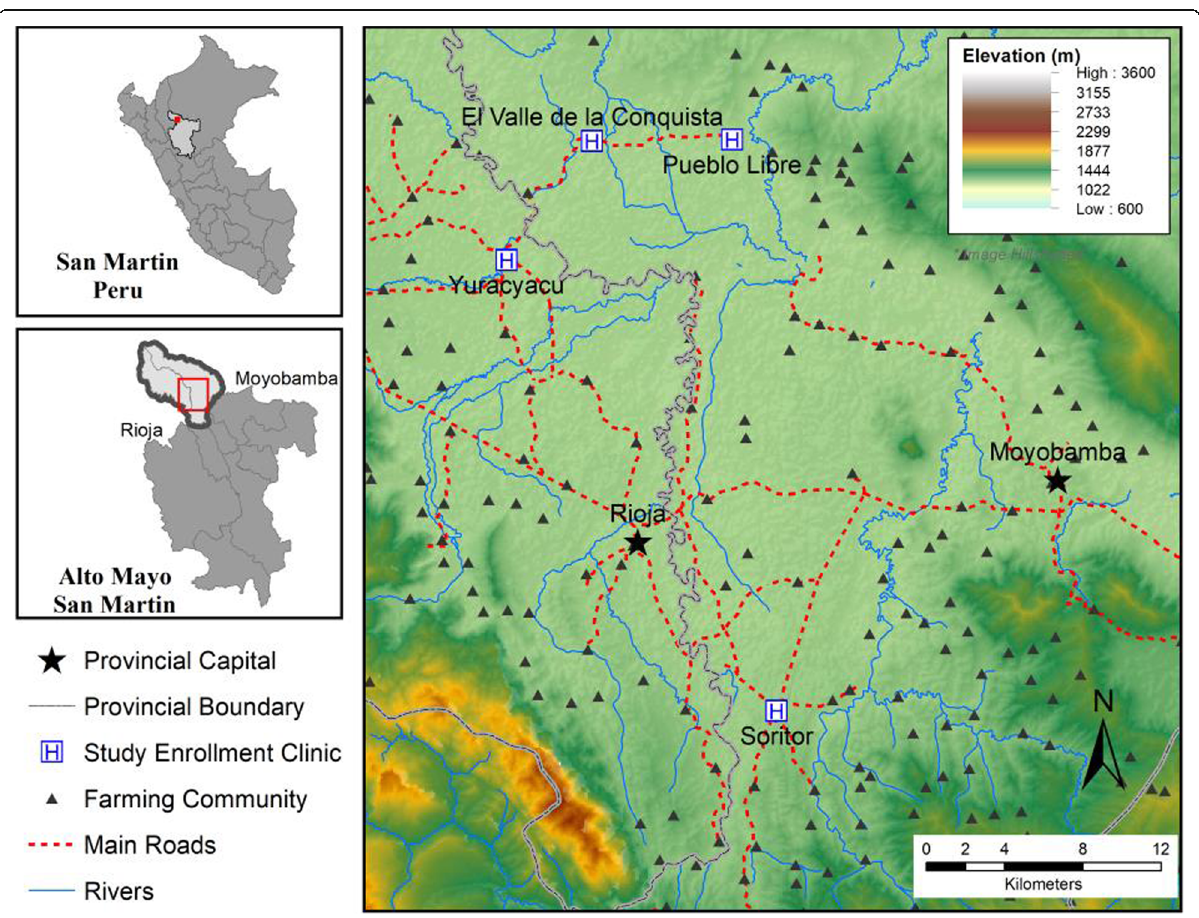
Fig. 1 Rioja and Moyobamba provincial regions comprise the area known as the Alto